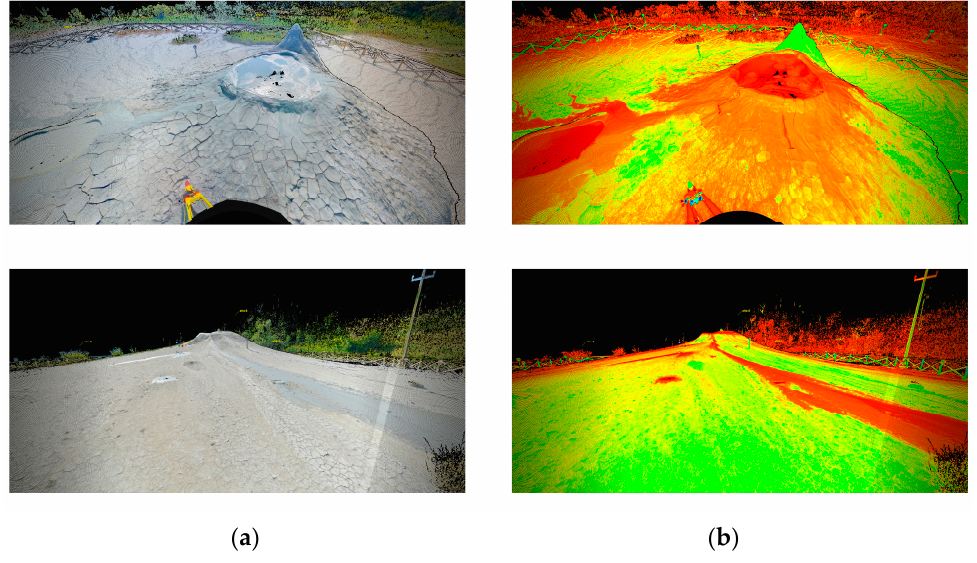
Figure 3. Point cloud from terrestrial laser scanning visualized with RGB values ( a ) and intensity value ( b ).